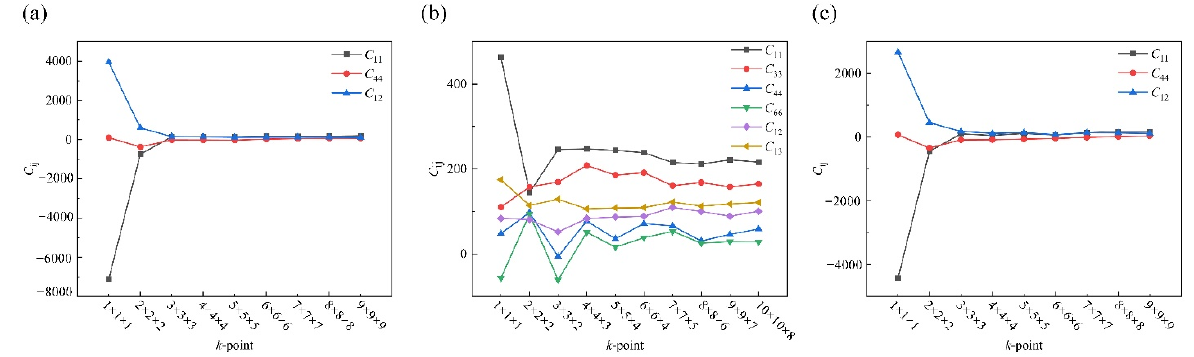
Figure A2. The relationship between k -point and elastic constants C ij : ( a ) AuCu 3 , ( b ) AuCu, ( c ) Au 3 Cu.